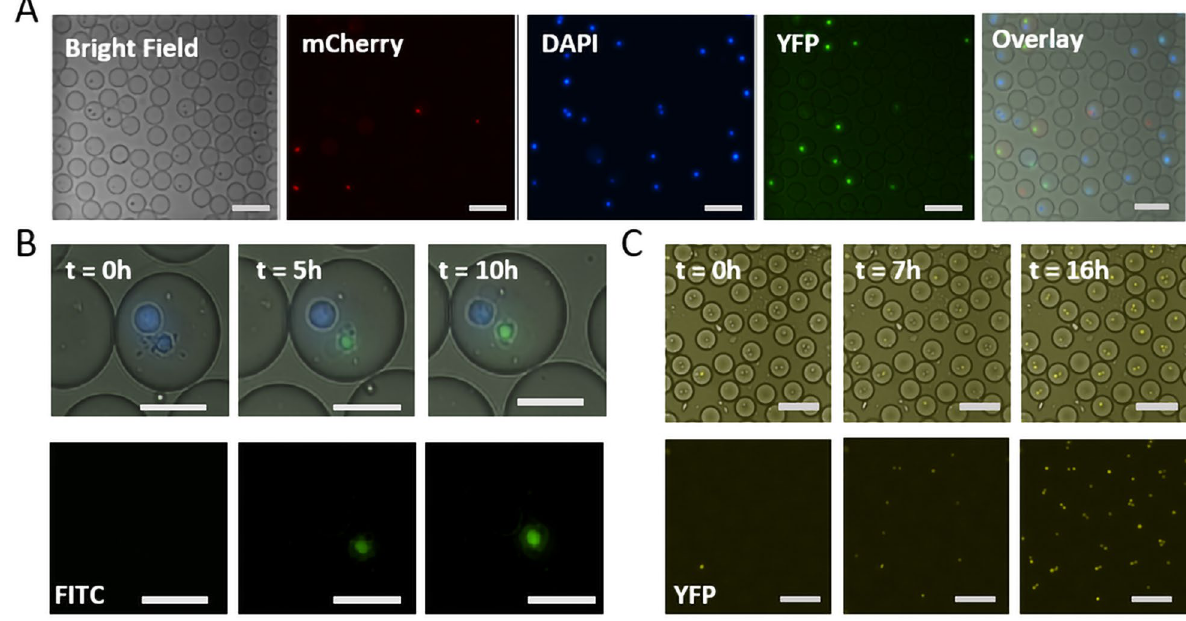
Figure 3. Real-time viability tracking. NK cells and target cells (here K562 cells and Jurkat T cells) were labelled with Calcein Red AM (5 µM) and Cell Tracker Blue (10 µM), respectively. The viability dyes Sytox